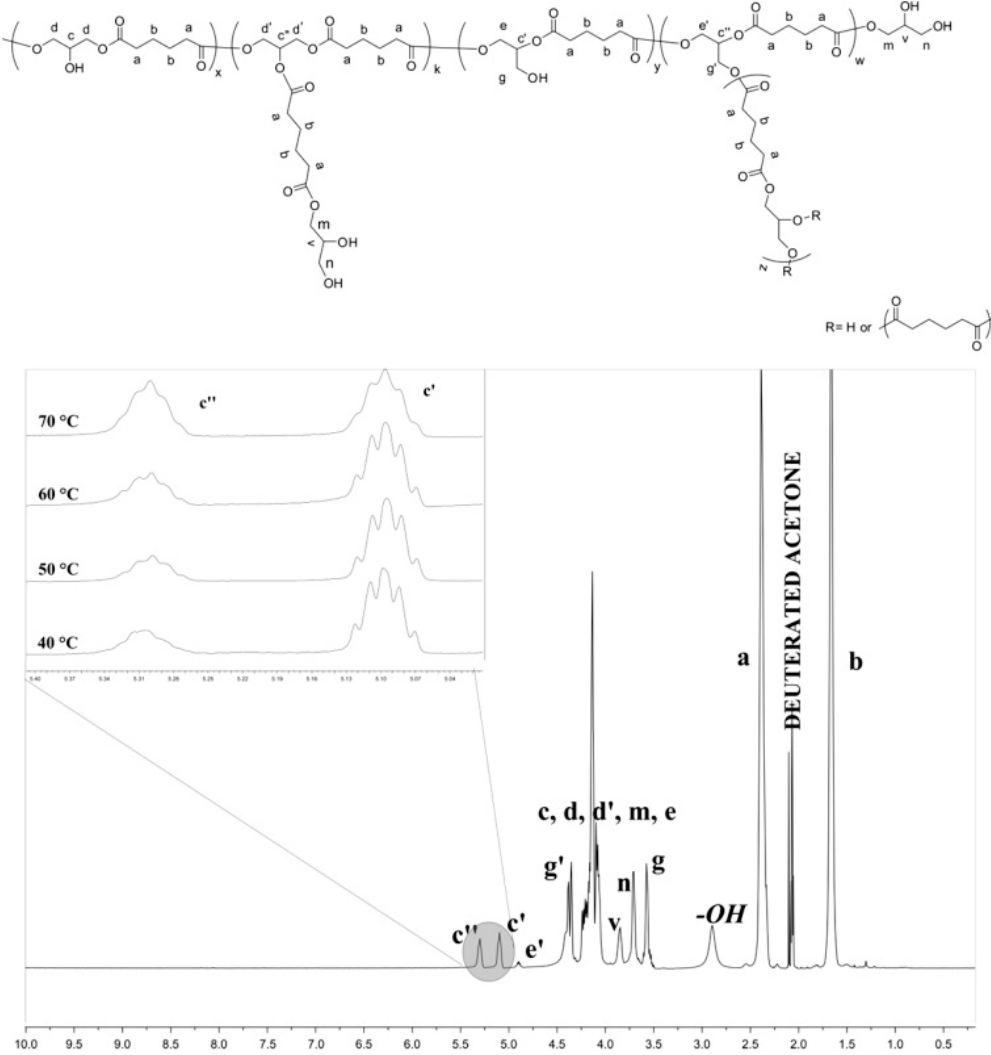
Figure 1. Poly (glycerol adipate) (PGA) macromolecular structure with triol-substitution modalities. 1 H NMR spectrum of PGA synthesized at 70 °C. Inset: Effect of reaction temperature on PGA degree of branching. Reproduced from [17], Copyright Elsevier 2016.